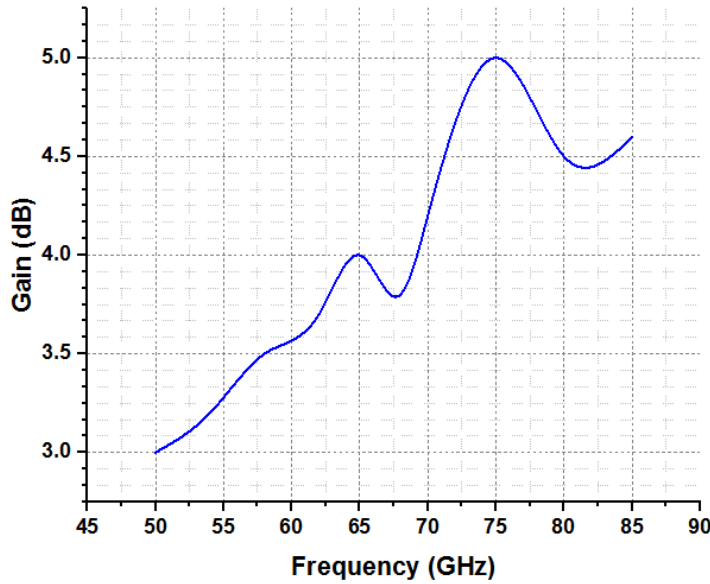
Figure 12. Investigation of gain as function of frequency. Table 3. Description of the designed model and achieved outcomes by presented model.